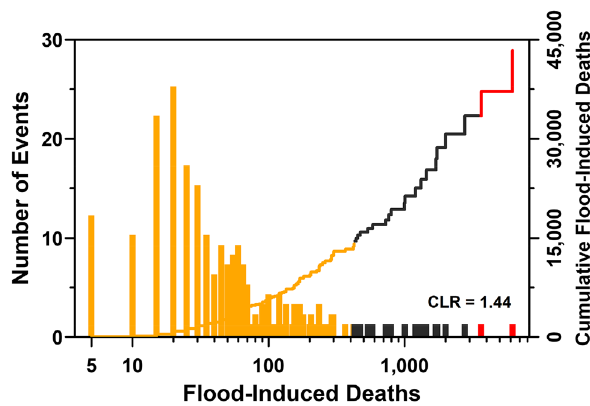
Fig. 1 Cumulative loss plot showing the distribution of flood- induced deaths of China. Data are from the EM-DAT archive, over the period from 1976 to 2016. The histogram has a bin width of 5 persons and log-scale horizontal axis. The orange bars indicate deaths due to flood events with a return period below 2 years, the red bars are deaths due to flood events with a return period over 20 years, and the black bars with an in-between return period. The orange-black-red curve and the right vertical axis depict the cumulative flood-induced deaths. CLR represents cumulative loss